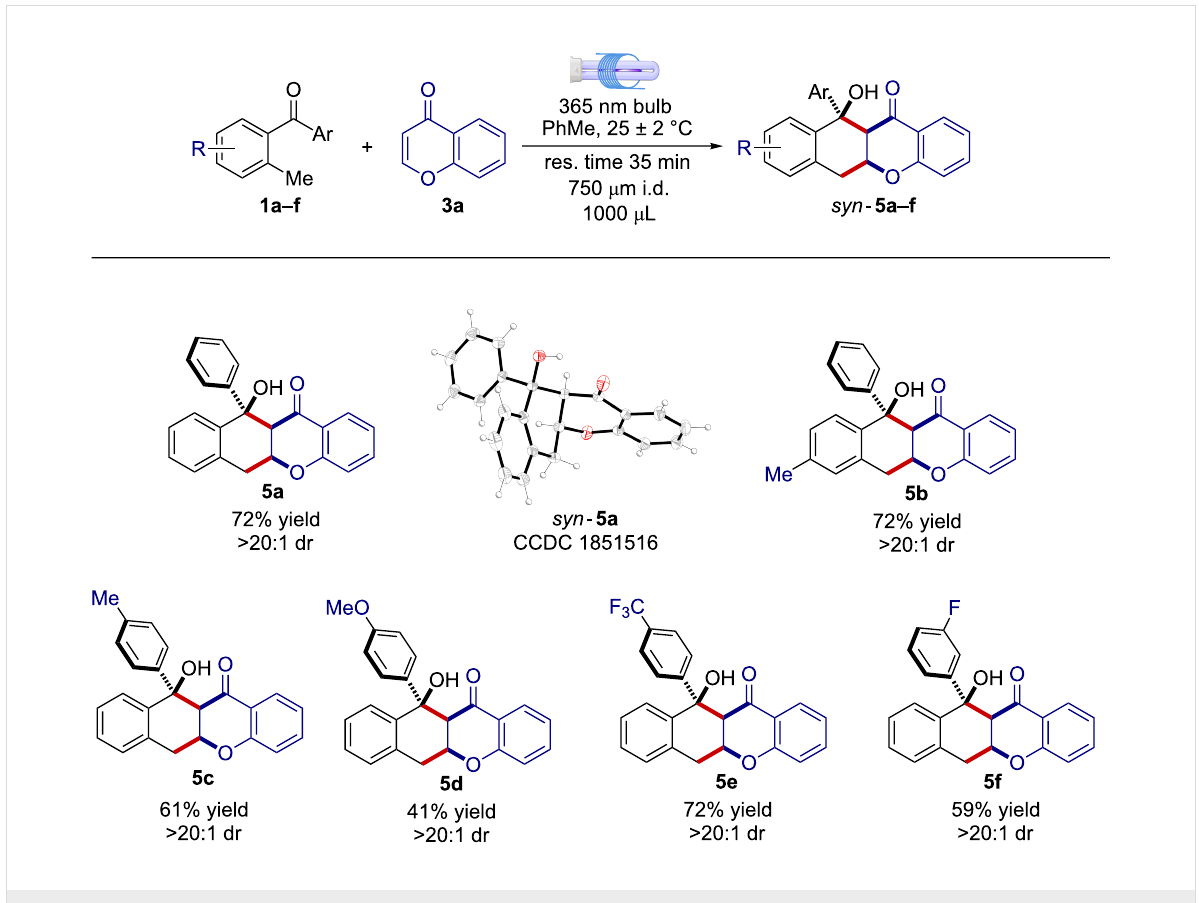
Figure 3: Generality and limits of the light-driven [4 + 2] cyclization reaction between 2-MBP 1a – f and chromone ( 3a ) under MFP setup.